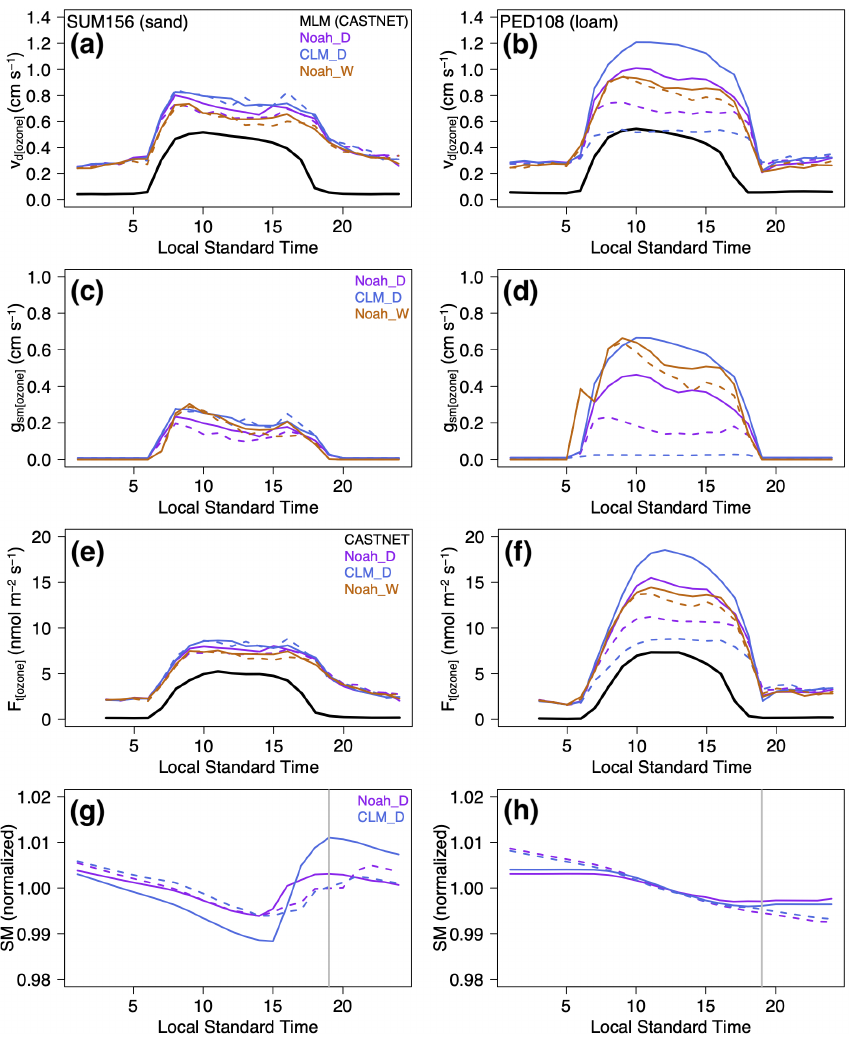
Figure 10. Period-mean (16–28 August 2016) diurnal cycles of (a, b) O 3 dry-deposition velocity v d and (e, f) O 3 dry-deposition flux F t based on the CASTNET dataset (shown by solid black lines) and their WRF-Chem counterparts (purple, blue, and brown lines) at the (a, c, e, g) SUM156 and (b, d, f, h) PED108 sites, whose locations are shown in Fig. 1d. Panels (c) and (d) and (g) and (h) indicate the diurnal variability of WRF-Chem stomatal–mesophyll conductance g sm and column-averaged soil moisture (normalized) at these two sites, respectively. The grey vertical lines in (g) and (h) denote the initial times of WRF-Chem. WRF-Chem results from the no-DA and DA cases are indicated by solid and dashed lines, respectively. Additional time series plots indicating the daily variability of these fluxes are shown in Fig.